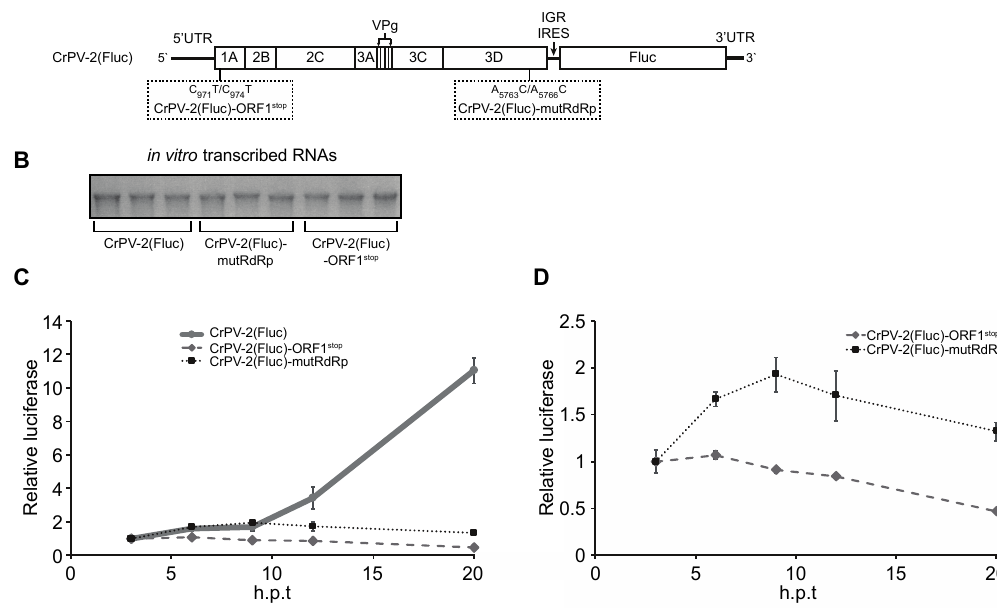
Figure 7. Non-structural viral proteins promote IGR IRES translation. ( A ) Schematics of the CrPV2(Fluc), CrPV2(Fluc)-ORF1 stop and CrPV2(Fluc)-mutRdRp replicons; ( B ) In vitro transcribed CrPV2(Fluc), CrPV2(Fluc)-ORF1 stop and CrPV2(Fluc)-mutRdRp RNAs that were used in the transfections as shown in ( C , D ); ( C ) Firefly luciferase activities from S2 cells transfected with CrPV2(Fluc), CrPV2(Fluc)-ORF1 stop and CrPV2(Fluc)-mutRdRp RNAs at different time points transfection. The results are normalized to its respective three-hour post transfection (h.p.t); ( D ) Results are from ( C ) but only showing CrPV-2(Fluc)-ORF1 stop and CrPV(FLuc)-mutRdRP. Shown are results from an average of three independent experiments (±s.d.).